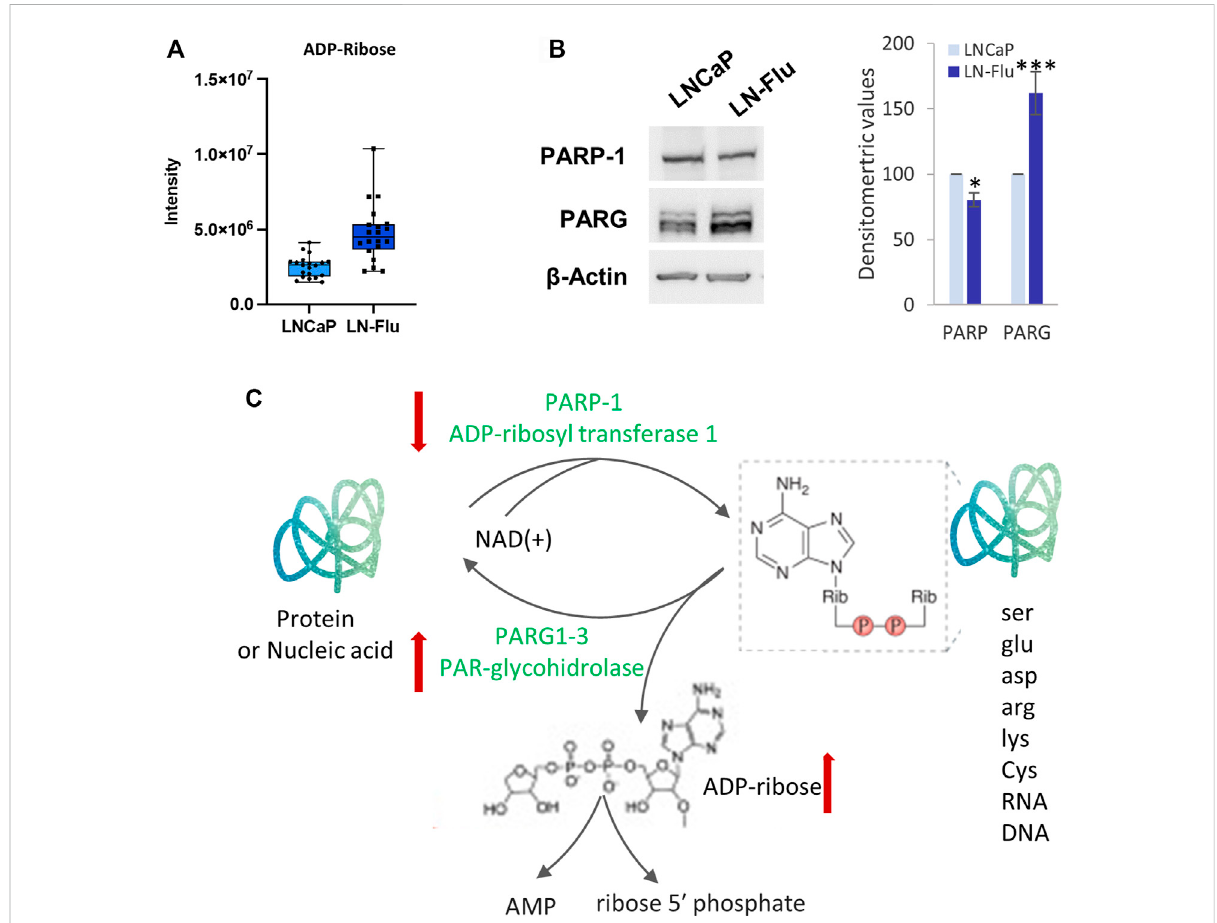
FIGURE 8 ADP-ribosylationismodi fi edinthedrug-resistantcancerstemcellsLN-Flu. (A) Boxandwhiskerplotofmetabolites involvedinthepathway. (B) Levels of ADP-ribosyl transferase 1 (PARP-1) and PAR-glycohydrolase (PARG1-3) determined by Western blot. Densitometric analysis of the western blot bands from three independent experiments is shown on the right. Results are the mean ± S.D. of three independent experiments. * p < 0.05 and ** p < 0.01 signi fi cant difference between LNCaP and LN-Flu cells by two-way ANOVA and Sidak ’ s multiple comparisons test. (C) ADP- ribosylation reaction showing themetabolites and enzymeswe have found up (red arrowup) or down (redarrowdown) in LN-Flu cells compared to LNCaP